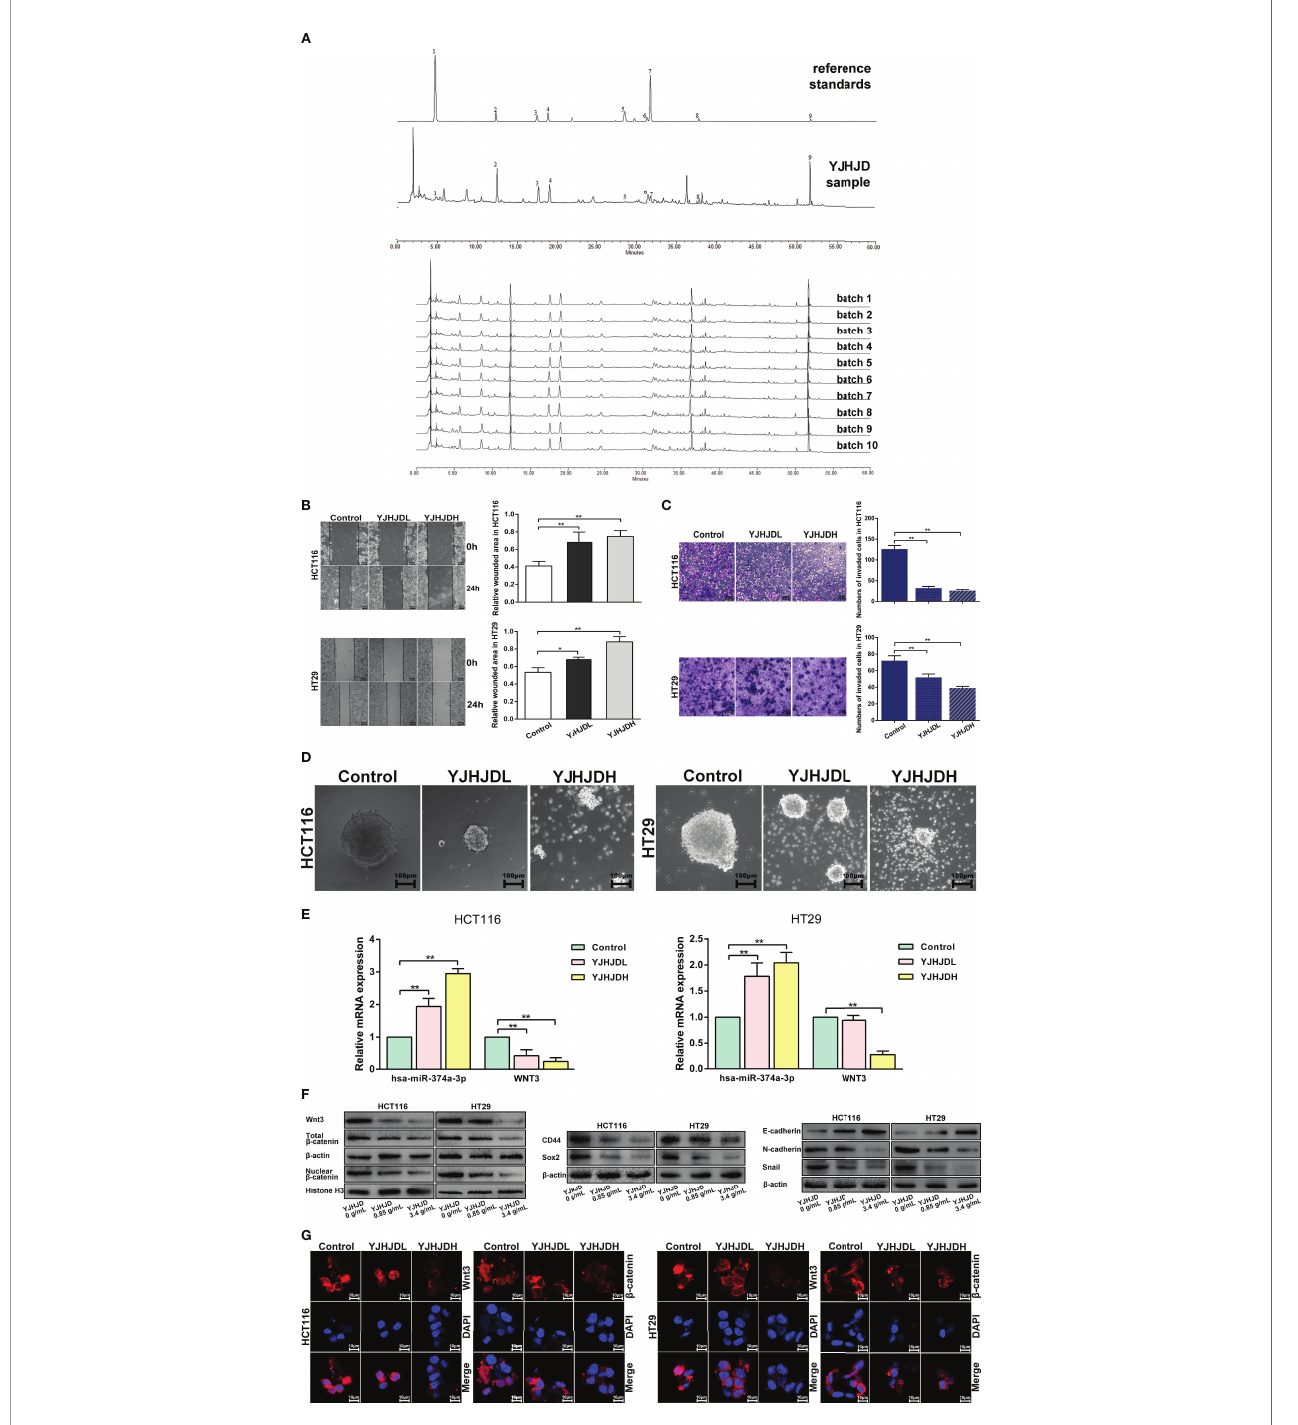
FIGURE 5 | YJHJD prohibits EMT, cellular plasticity, and hsa-miR-374a-3p/WNT3/ b -catenin axis-related molecules in COAD cells. (A) The HPLC fi ngerprint of YJHJD was established and compared with the reference standards. (B) Migration ability was tested by wound-healing assay. (C) Cell invasion ability was measured through transwell assay. (D) Cellular plasticity was assessed by spheroid formation assay. (E) mRNA expression of hsa-miR-374a-3p and WNT3 in response to YJHJD was evaluated by PT-PCR assay. (F) WNT3/ b -catenin, EMT, and cellular plasticity-associated markers at protein levels were estimated by Western blot assay. (G) Protein expression and location of Wnt3 and b -catenin in COAD cells were tested via immuno fl uorescence analysis. *P < 0.05, **P < 0.01 compared to control